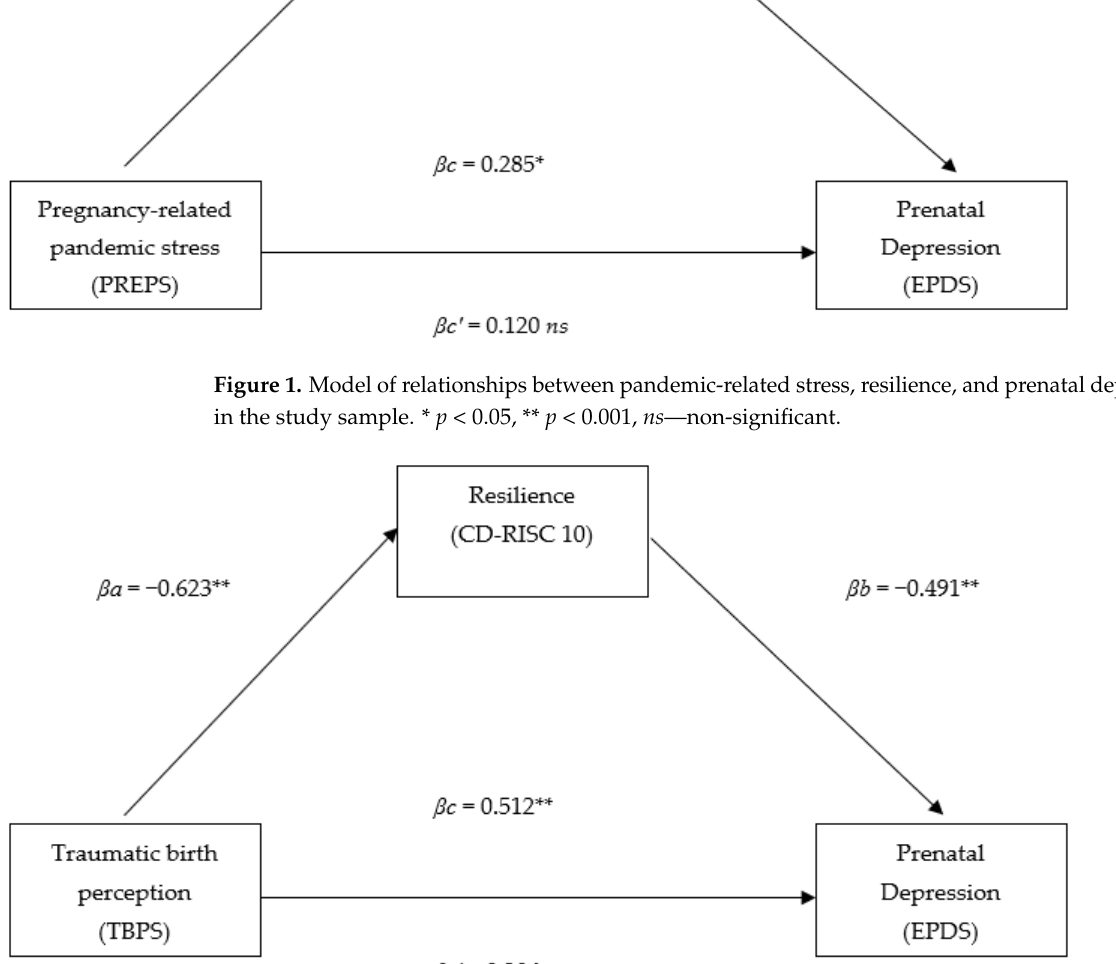
Figure 2. Model of relationships between traumatic birth perception, resilience, and prenatal depression in the study sample. ** p < 0.001; ns— non-significant.